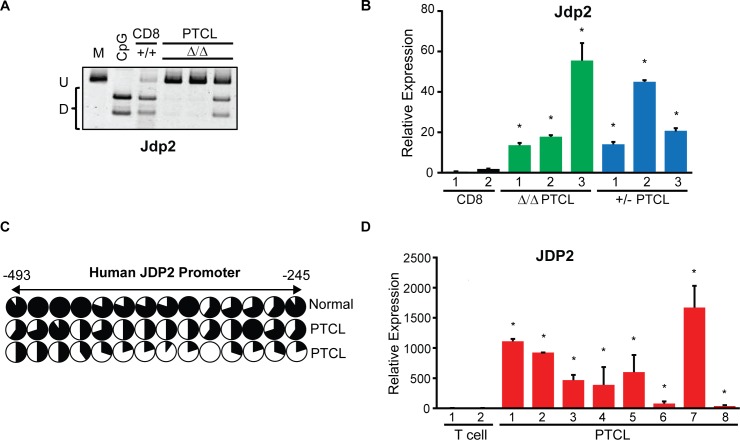
Jdp2 is hypomethylated and overexpressed in human and mouse PTCL.(A) COBRA analysis of mouse Jdp2 promoter methylation in three independent Dnmt3aΔ/Δ PTCL samples. Undigested (U) and digested (D) fragments correspond to unmethylated and methylated DNA, respectively. Control PCR fragments generated from fully methylated mouse genomic DNA that is undigested (M) or digested (CpG) are shown. (B) Normalized gene expression of Jdp2 in mouse CD8+ control, Dnmt3a+/- PTCL, and Dnmt3aΔ/Δ PTCL samples by qRT-PCR. Data presented are the average of two independent experiments. Error bars show standard deviation and an asterisk (*) denotes a p<0.05 (student t-test). (C) Bisulfite sequencing of the JDP2 promoter in normal human CD3+ T cells and in two independent human PTCL samples. Circles represent individual CpGs within the promoter. Black and white areas denote the relative portion of methylated and un-methylated sequence reads at a CpG, respectively. (D) Normalized gene expression of JDP2 in normal human CD3+ T cells and human PTCL samples, by qRT-PCR. Data presented are the average of two independent experiments. Error bars show standard deviation and an asterisk (*) denotes a p<0.05 (student t-test).